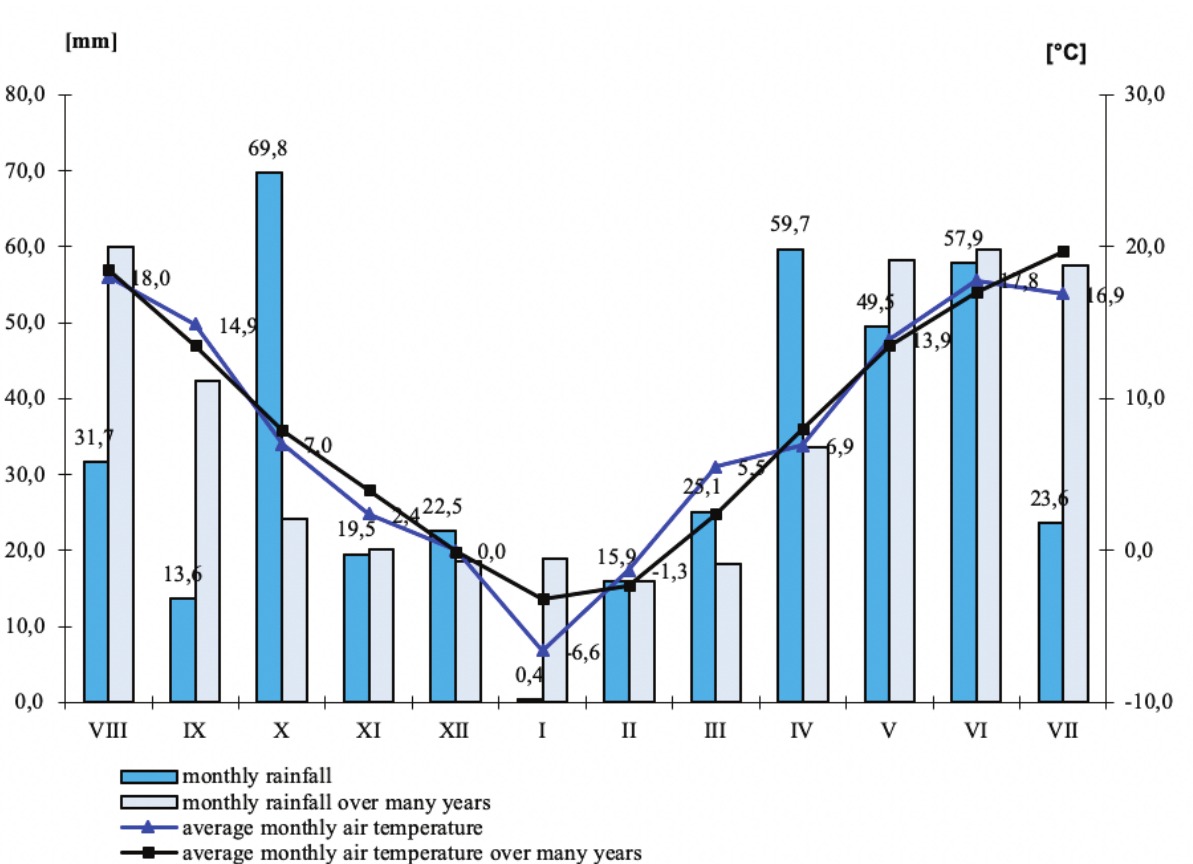
Figure 2: Monthly rainfall totals and average air temperature during the growing season 2016-2017 in RSD Zawady of many years of many years